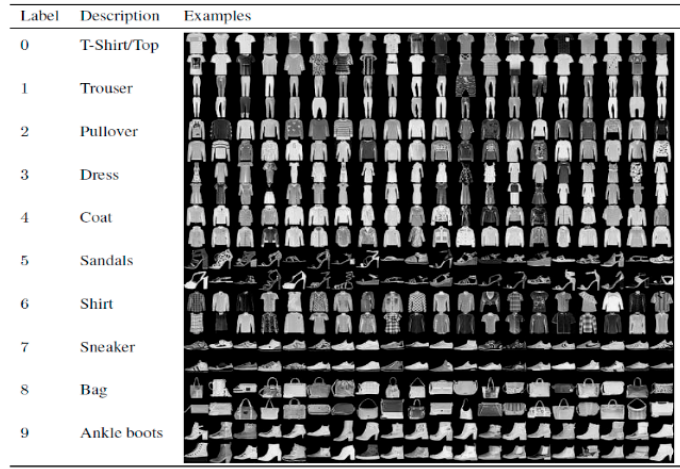
Figure 4. Fashion-MNIST dataset images and labels [6,16].